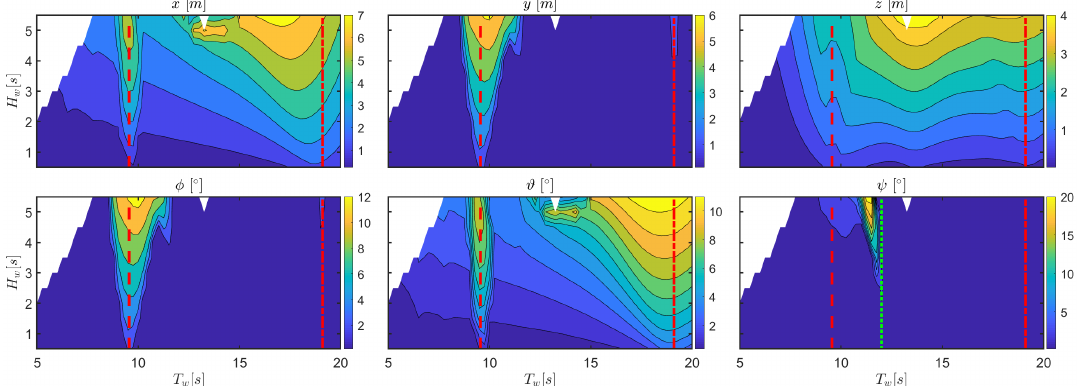
T n ,5 and T w = T n ,5 , respectively. 2